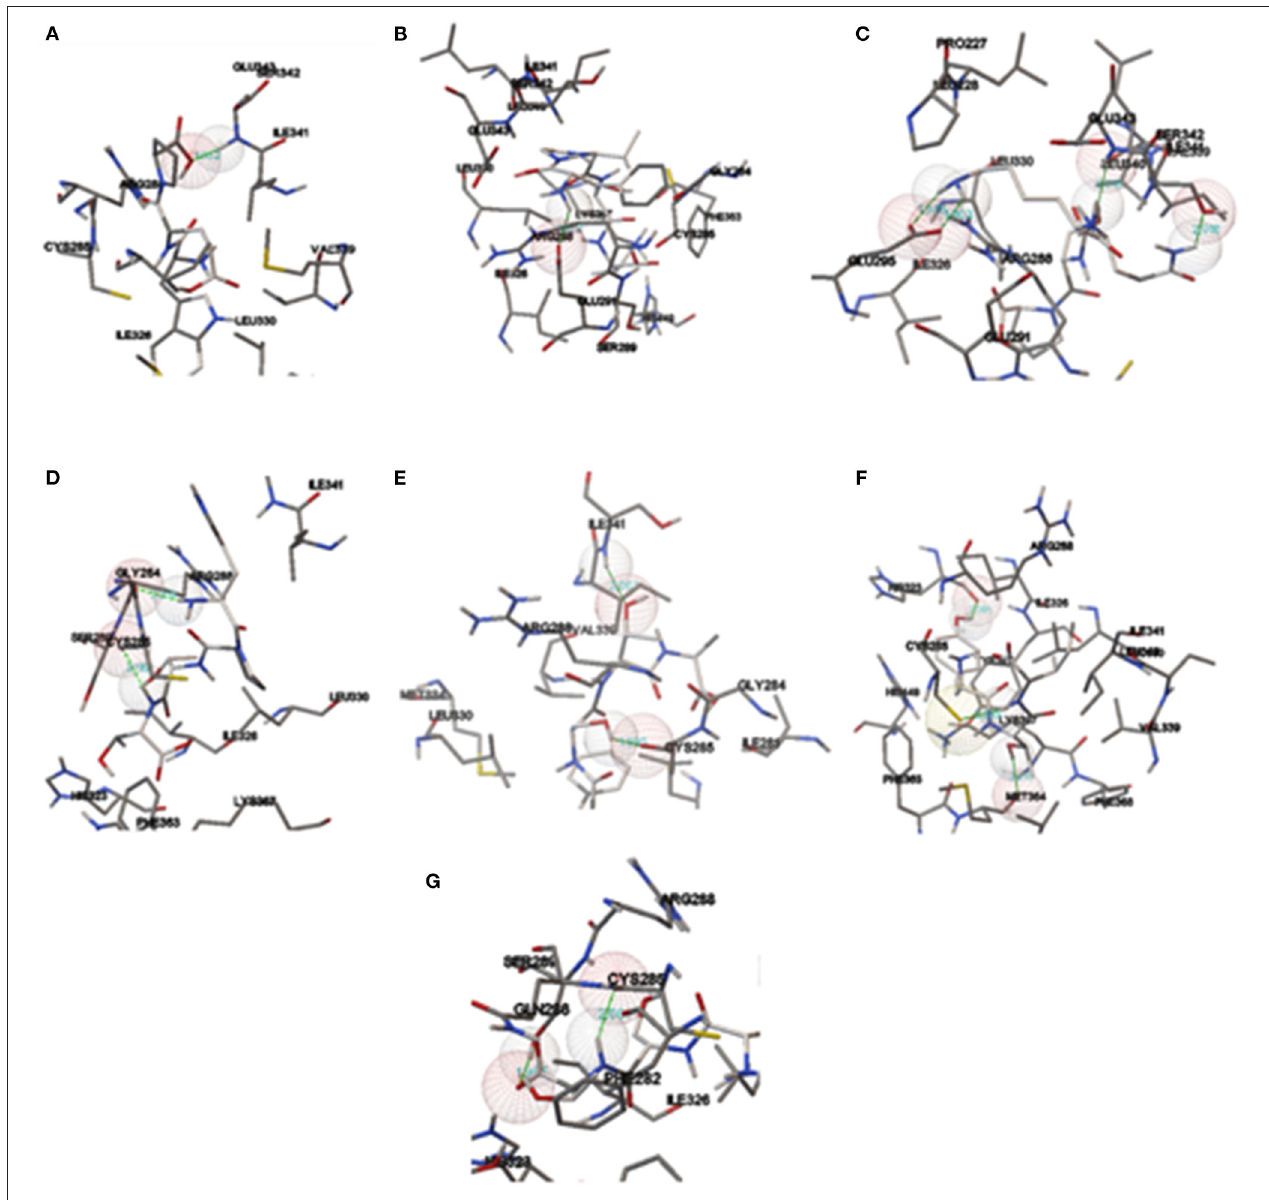
FIGURE 3 | Intermolecular ligand-receptor conjunctions between PPAR γ and peptides. (A) ITY, (B) TSF, (C) PEW, (D) PSQK, (E) TTPW, (F) ATSF, and (G) VSVGF.